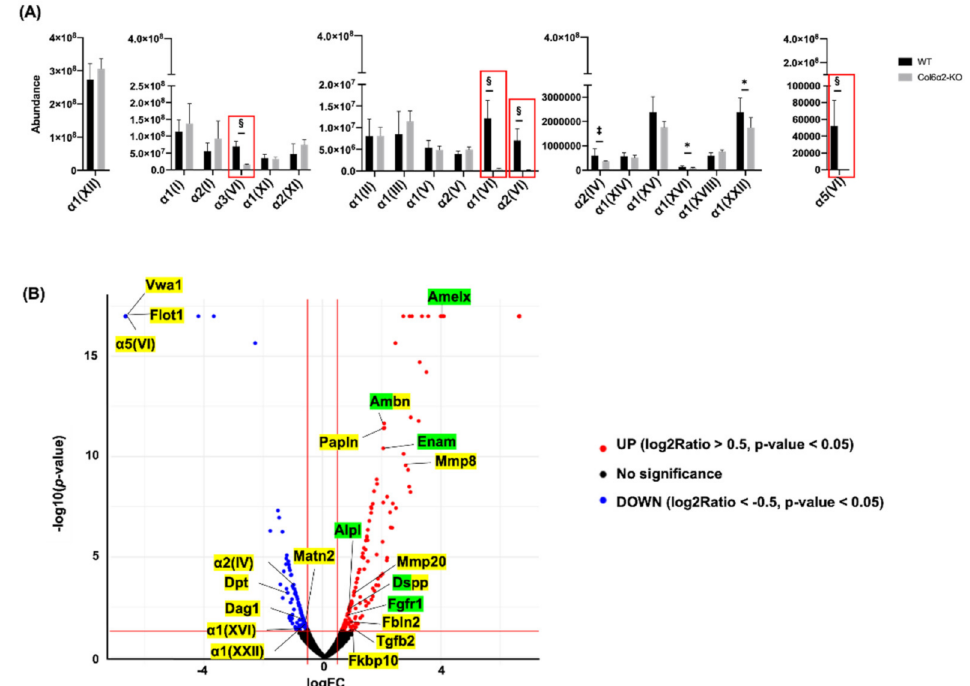
Figure 4. Proteome analysis with protein extracted from alveolar bone at 6-week of age. ( A ) The abundance of collagen detected in alveolar bone. ( B ) The volcano plot showing deferentially expressed proteins in Col6 α 2-KO mice alveolar bone. Green marked proteins represent molecules related to Biomineralization and yellow marked proteins represent molecules related to Extracellular matrix organization. Bars represent standard deviation ( n = 4/genotype) p -value: * p < 0.05, ‡ p < 0.005, § p <